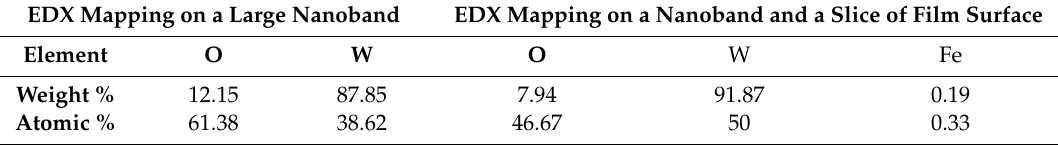
Table 4. The elemental composition of the S2 sample annealed at T = 750 ◦ C, on the large nanoband, and large nanoband with a slice of the film